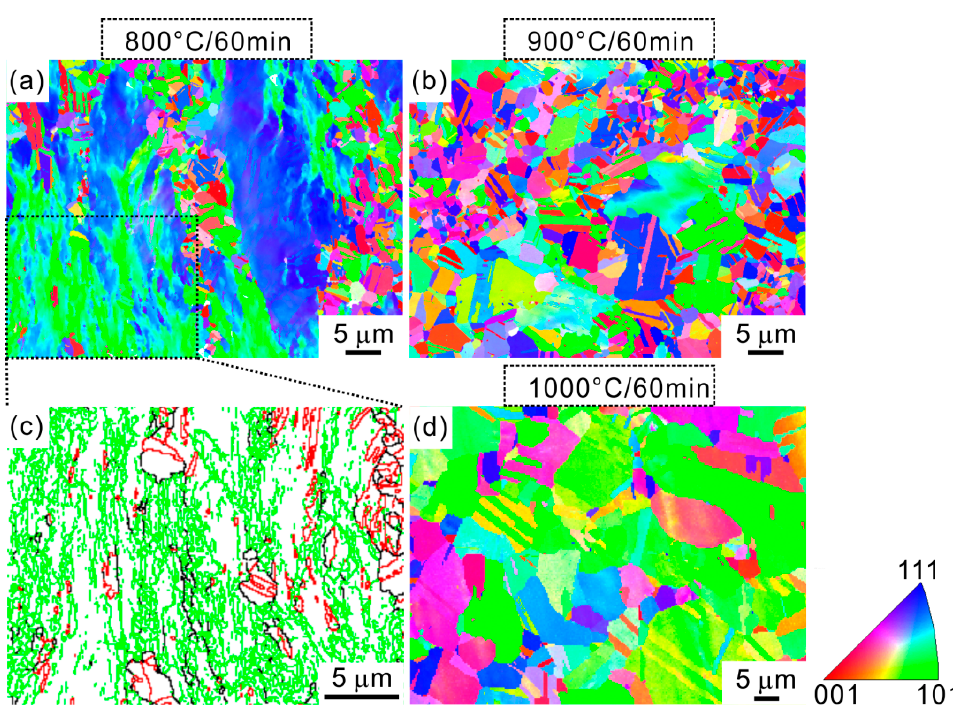
Figure 2. Inverse pole figure (IPF) maps recorded from ( a ) 800 °C, ( b ) 900 °C, and ( d ) 1000 °C an- nealed HEA specimens. ( c ) is grain boundary map from rectangle region in ( a ). annealed HEA specimens. ( c ) is grain boundary map from rectangle region in ( a